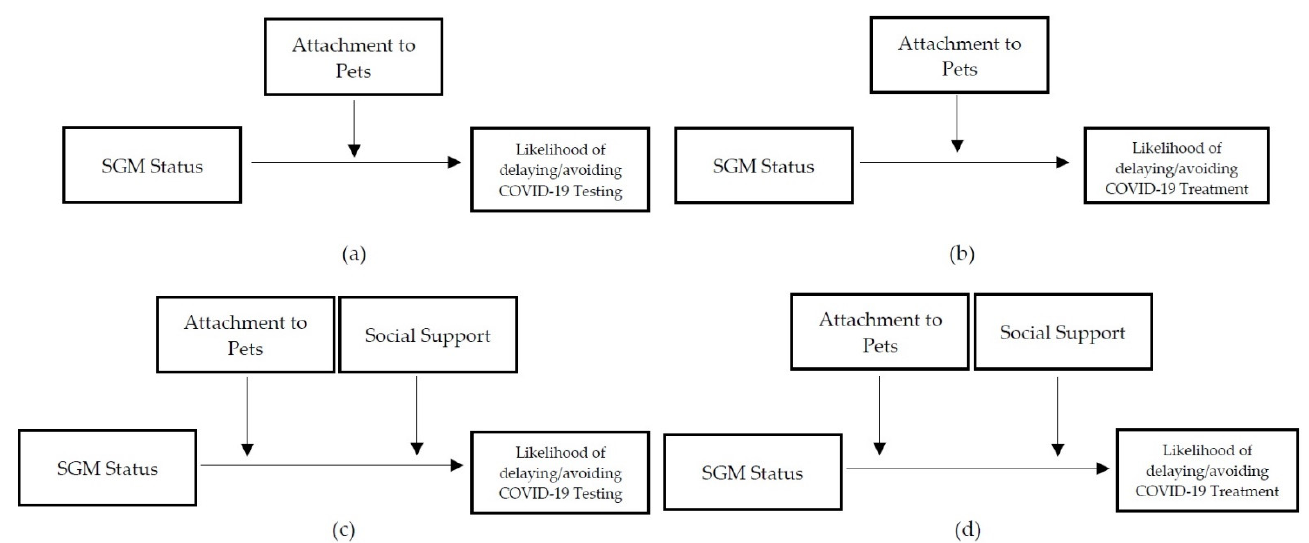
Figure 1. Conceptual models for the moderation analyses. Covariates are not shown in the figures for clarity. ( a ) Simple moderation model with the likelihood of delaying or avoiding COVID-19 testing as the outcome. ( b ) Simple moderation model with the likelihood of delaying or avoiding COVID-19 treatment as the outcome. ( c ) Additive multiple moderation model with the likelihood of delaying or avoiding COVID-19 testing as the outcome. ( d ) Additive multiple moderation model with the likelihood of delaying or avoiding COVID-19 treatment as the